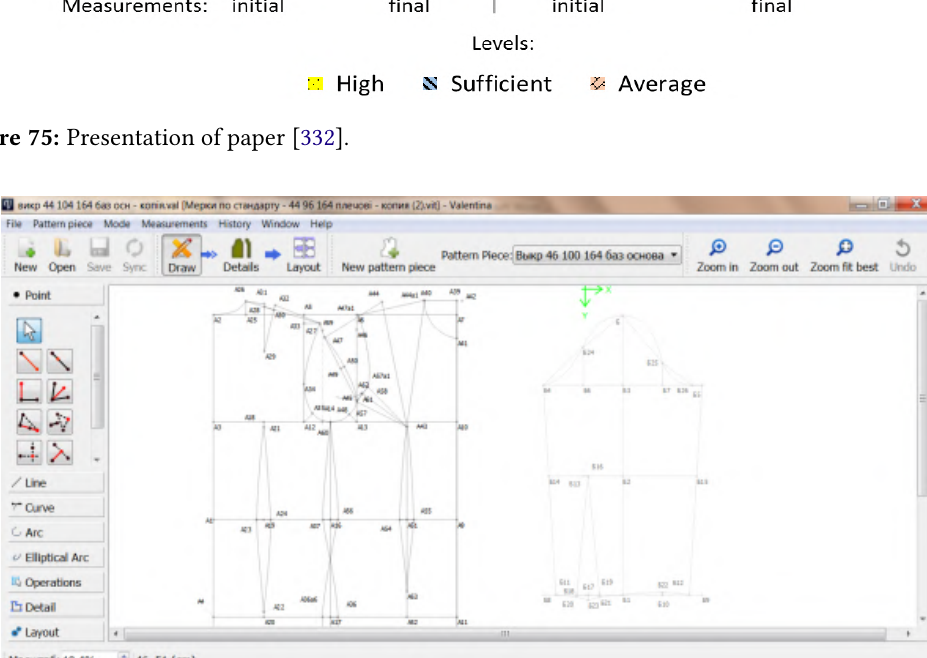
Figure 76: Presentation of paper